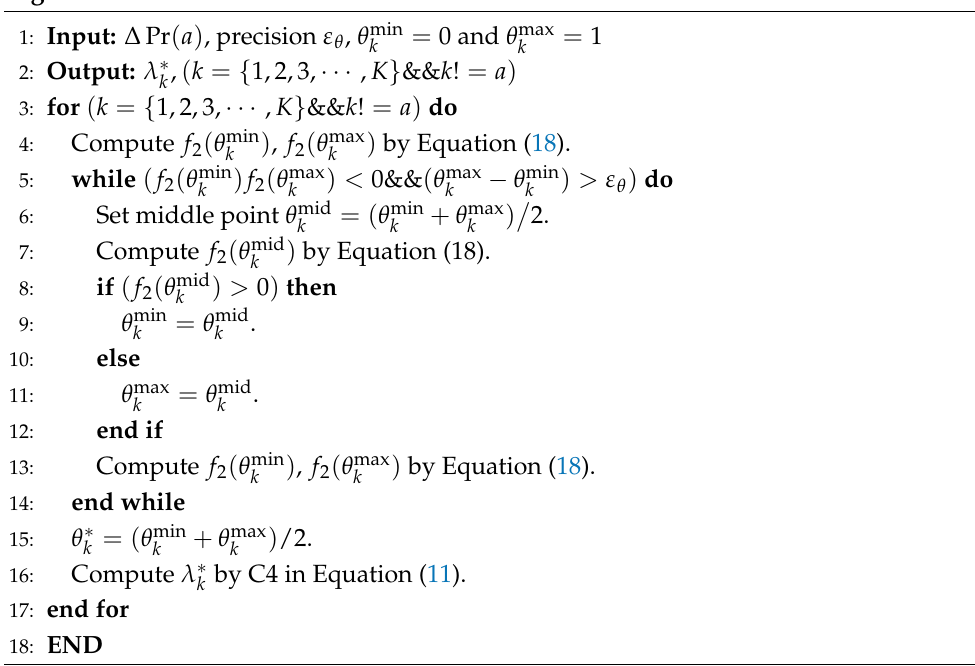
Algorithm 2 Task allocation